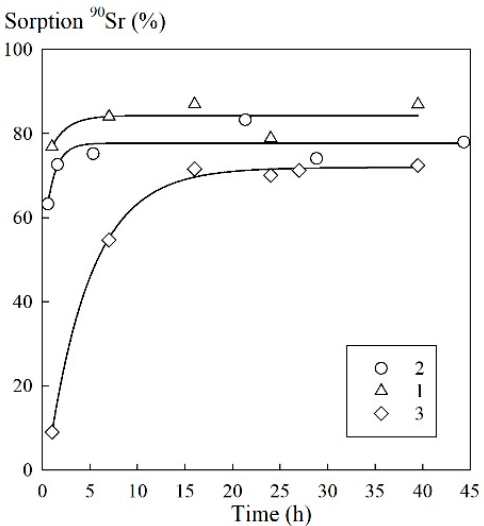
Figure 3. Kinetic curves of 90 Sr sorption from tap water. Sorbents 1A (1); 3M (2); and 1M (3).